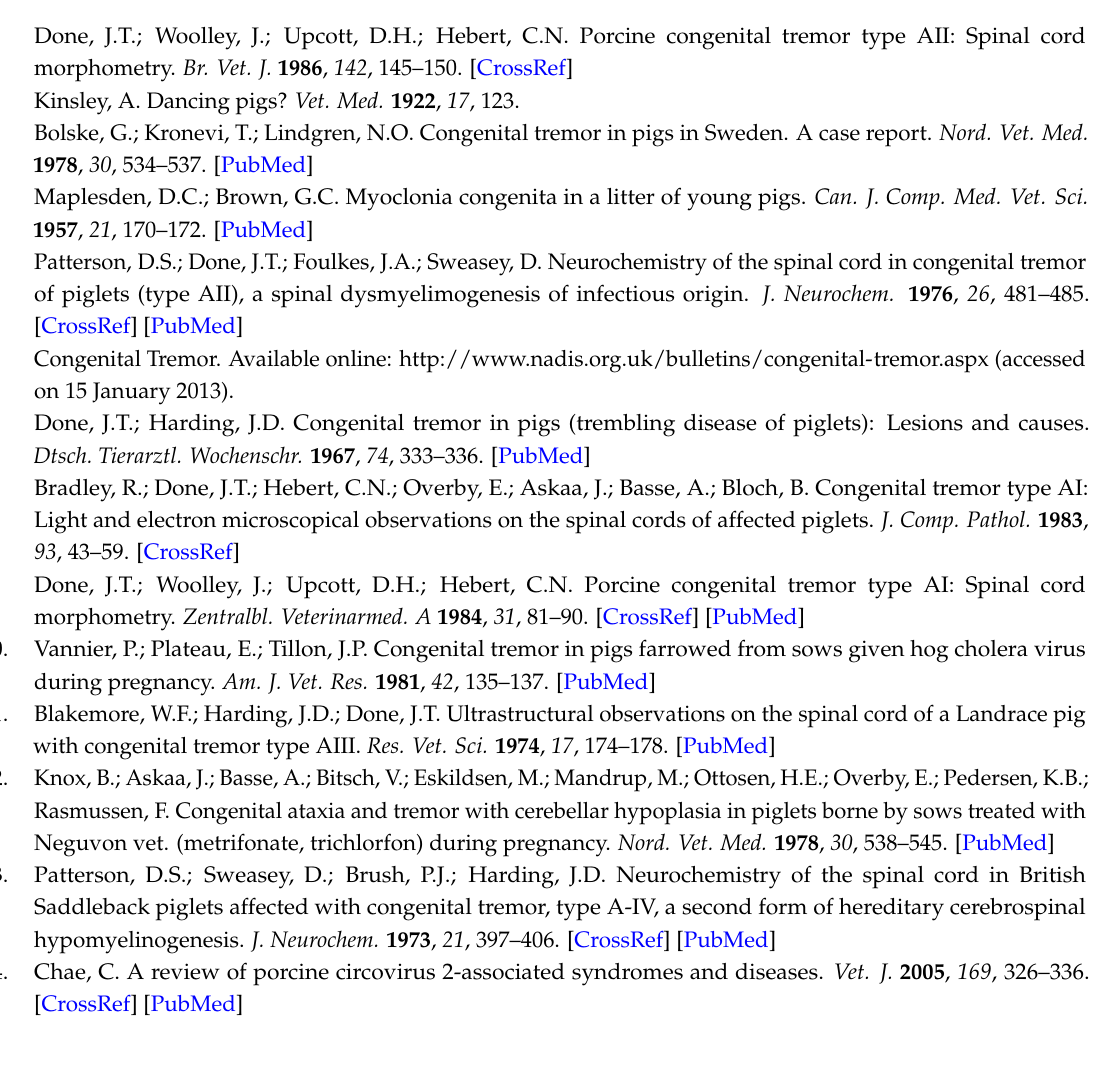
Figure S1 : Mean viral load in blood plasma of six weaning-aged piglets inoculated with tissue homogenate containing APPV; Figure S2 : Similarity plot of APPV types B, C, APPV-000515 compared to type A; Table S1 : Primers used for APPV PCRs; Table S2 : Nucleotide distance matrix of the region between nt 379 (position start codon APPV type A) and nt 4803 of APPV; Table S3 : APPV presence in serum at different ages; Table S4 : APPV presence in feces at different ages; Table S5 : APPV presence in preputial fluid; Table S6 : APPV RNA load in offspring of experimentally-infected